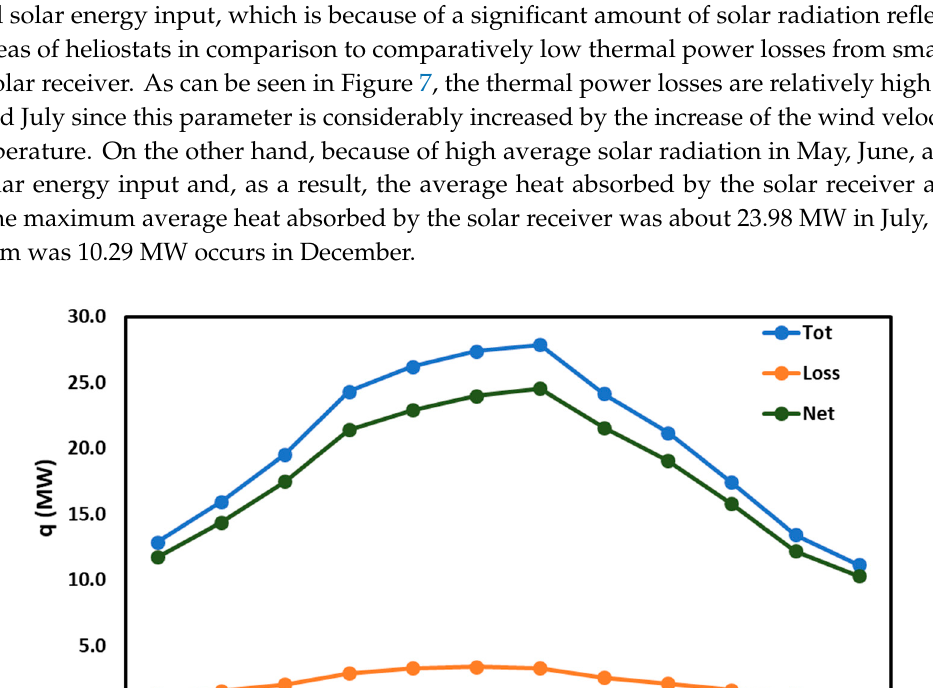
Figure 6. Monthly average optic efficiency of the heliostat in different months of a year.